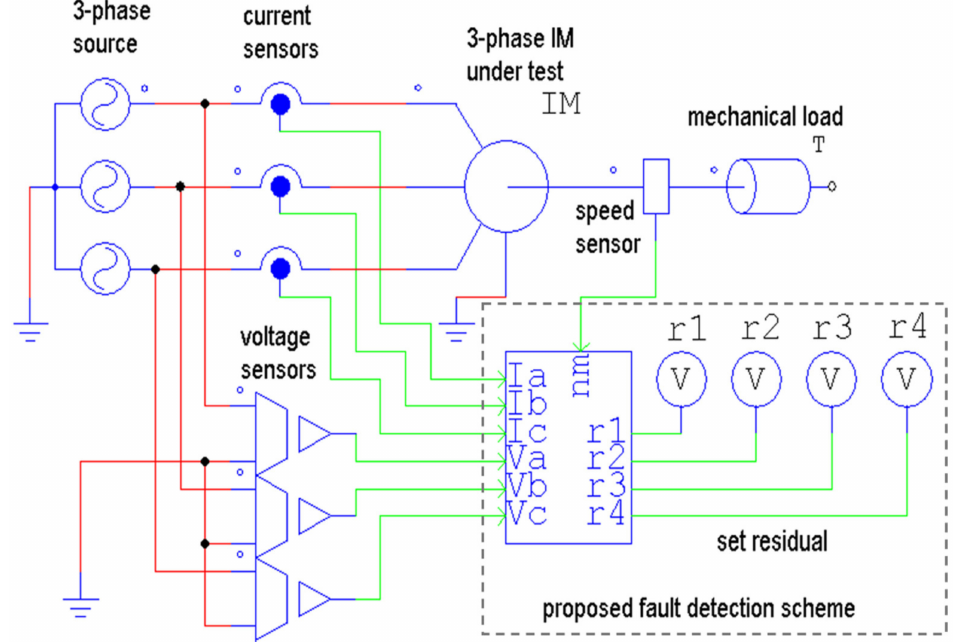
Figure 3. Main simulation and experimental scheme for fault diagnosis in the